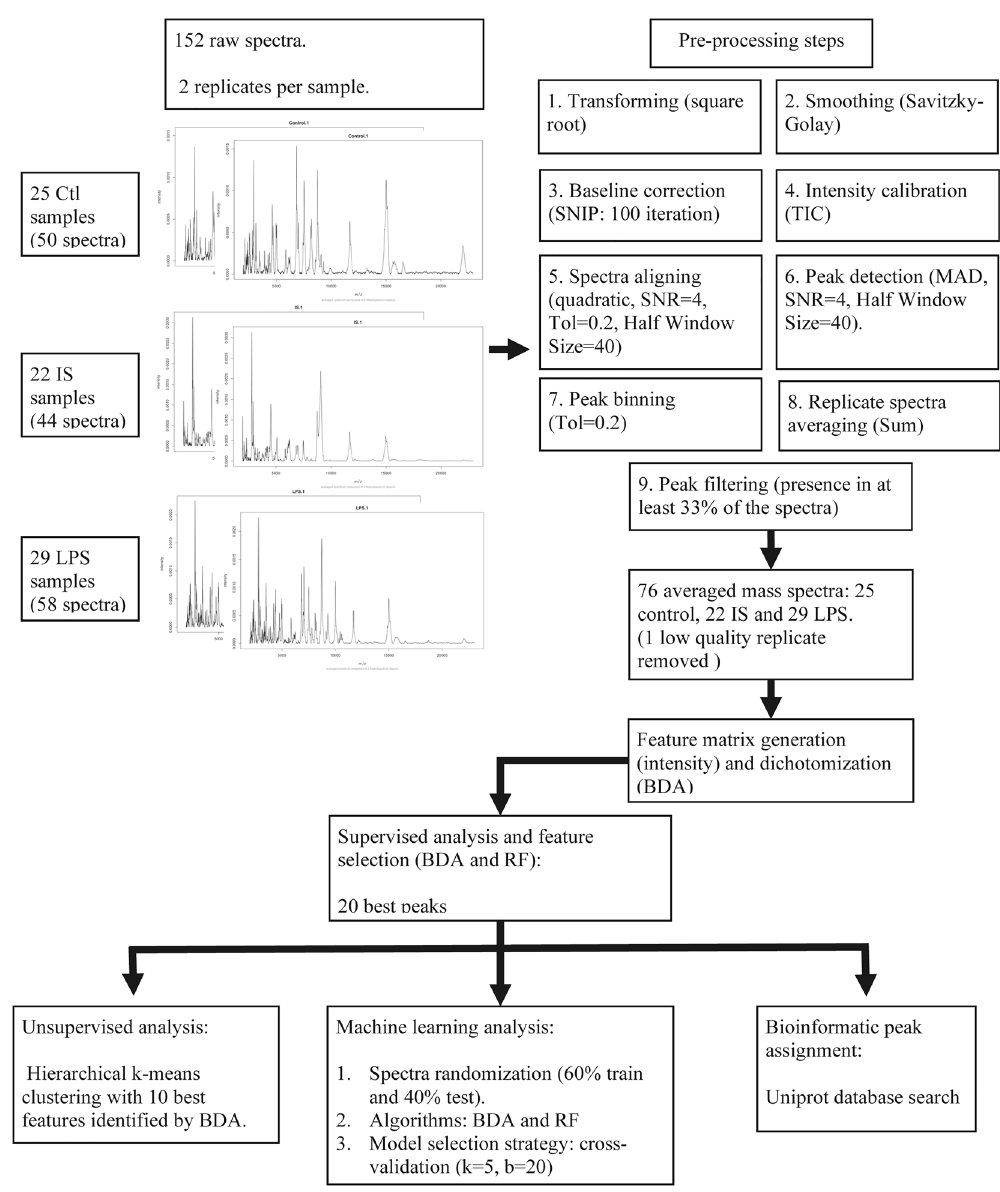
Figure 1. MALDI-TOF- MS data analysis pipeline. CTL, control group; IS, immunosuppression/anti- inflammatory group; LPS, pro-inflammatory group; BDA, binary discriminant analysis; RF, random